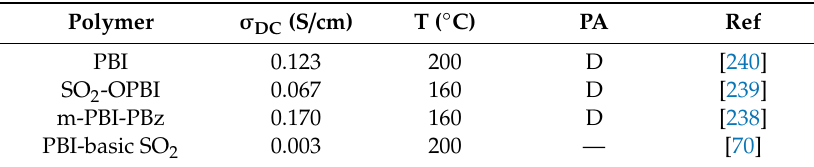
Table 11. Nanofibers polybenzimidazole